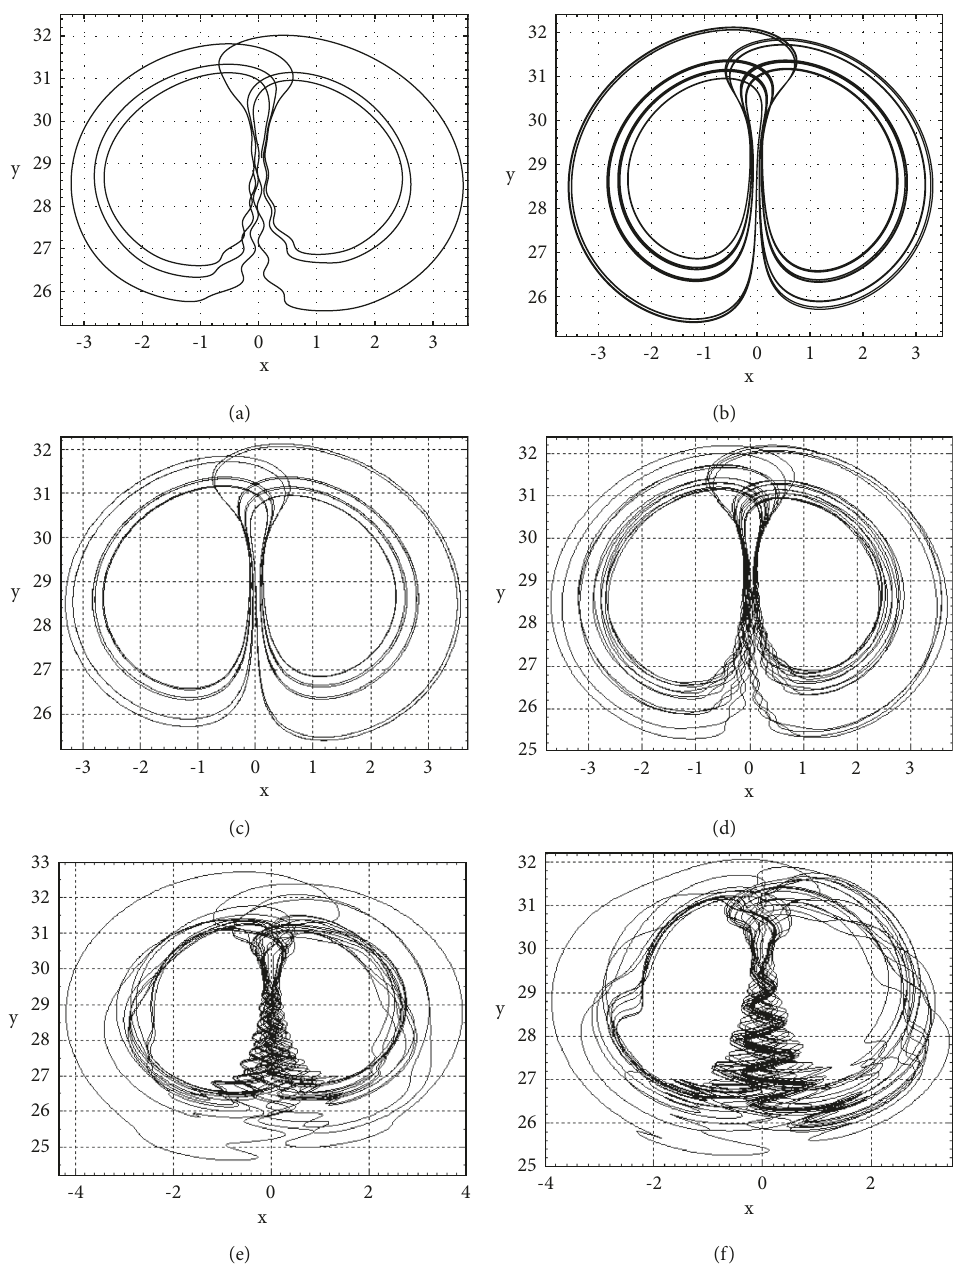
Figure 9: Phase portraits plotted for F � 1Hz; the initial conditions are ( x u � 0.009; v � 0.005; β � 0.03; σ � 1.56; (a) A � -1.0259, (b) A � − 4.6959, (c) A � 0.02, (d) A � 1, (e) A �− 5, and (f) A � −